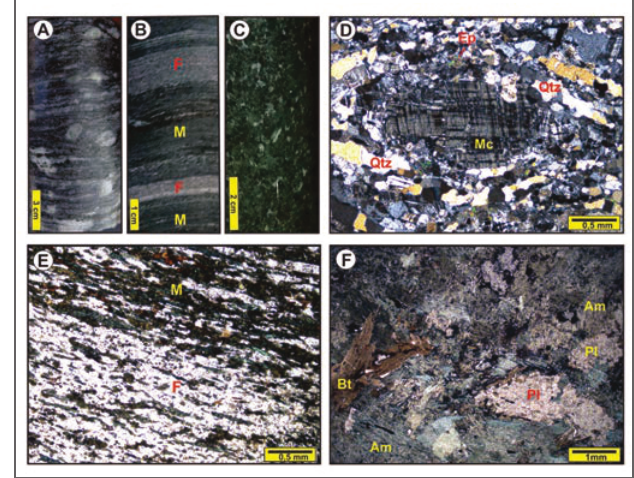
Figure 8 - Petrographic features of the lower compartment units: drill-cores showing porphyroclastic texture marked by feldspars in microaugen gneiss (A), mafic and felsic levels of banded gneiss (B) and thick inequigranular texture of metagabbronorite (C); (D) photomicrograph of microaugen with microcline porphyroclasts in quartz-feldspathic matrix (crossed Nicols); (E) photomicrograph of the banded gneiss (parallel Nicols) showing the alternation between the mafic (amphibole schist) and felsic (amphibole gneiss) phases; (F) photomicrograph of metamafic rock showing the mafic phases with amphibole and biotite, and felsic phases with plagioclase (parallel Nicols). Am = amphibole, Bt = biotite, Ep = epidote, Mc = microcline, Pl = plagioclase, Qtz = quartz. M = mafic band, F = felsic